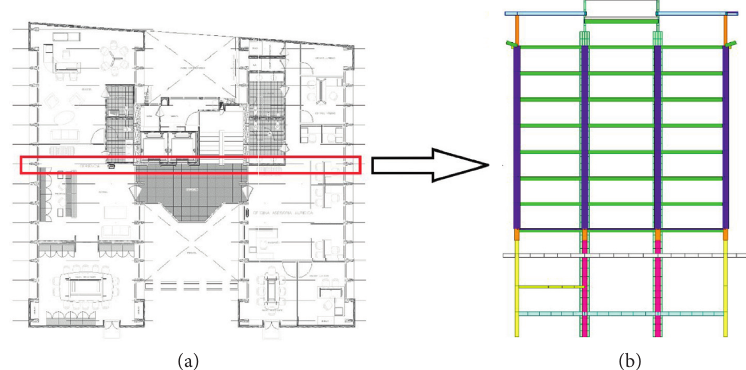
Figure 5: Structure details. (a) Typical plan configuration of the modelled building. (b) Plane frame modelled. Table 1: Modal properties of the plane frame